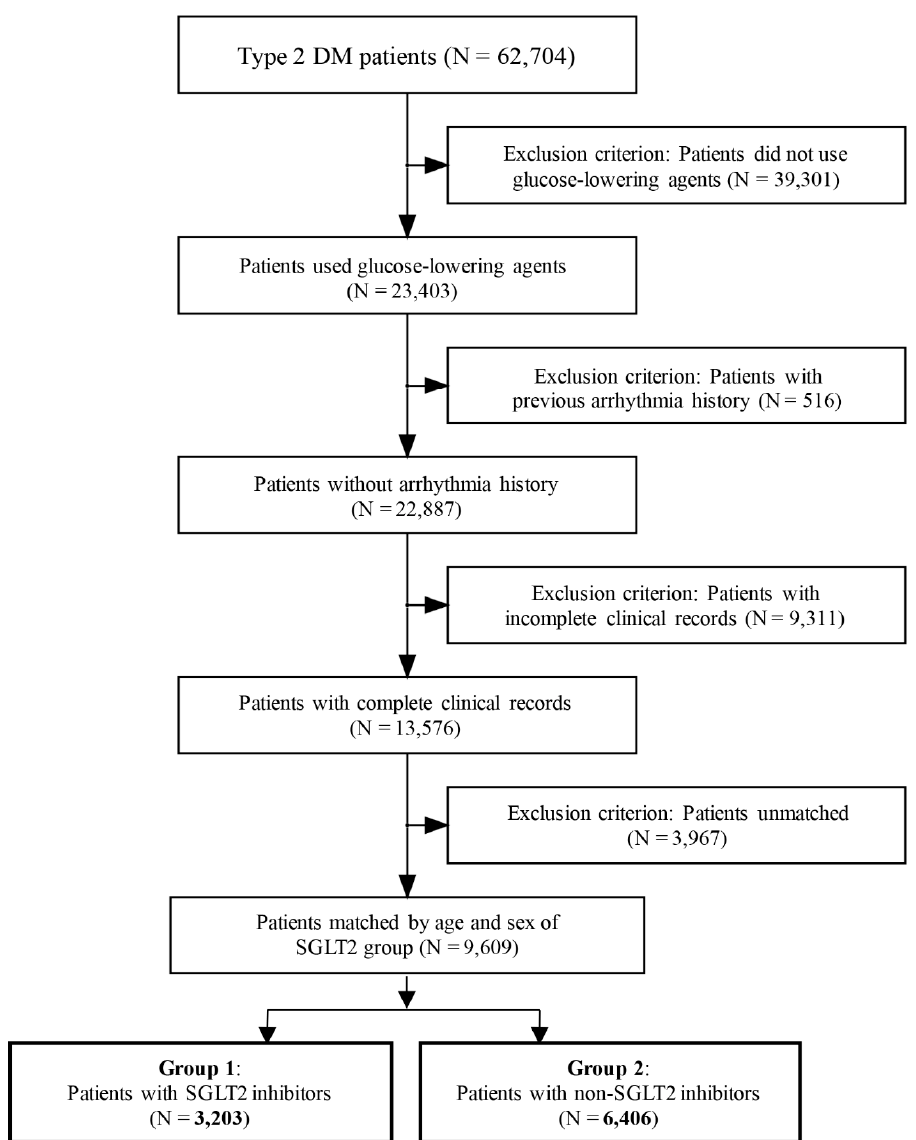
Figure 1. Flowchart of patients included in the current study and inclusion and exclusion criteria for the study proposal. Patients with SGLT2 inhibitor treatment were grouped into group 1, and those without SGLT2 inhibitors were included into group 2.